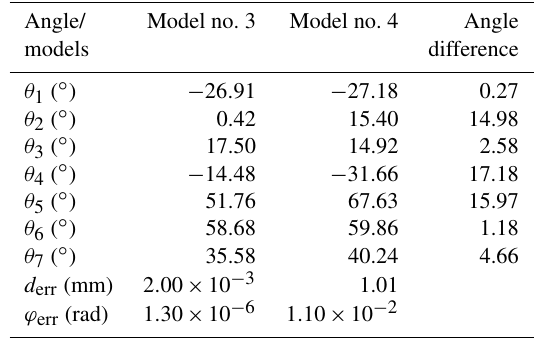
Table 5. Simulation result using the models with different